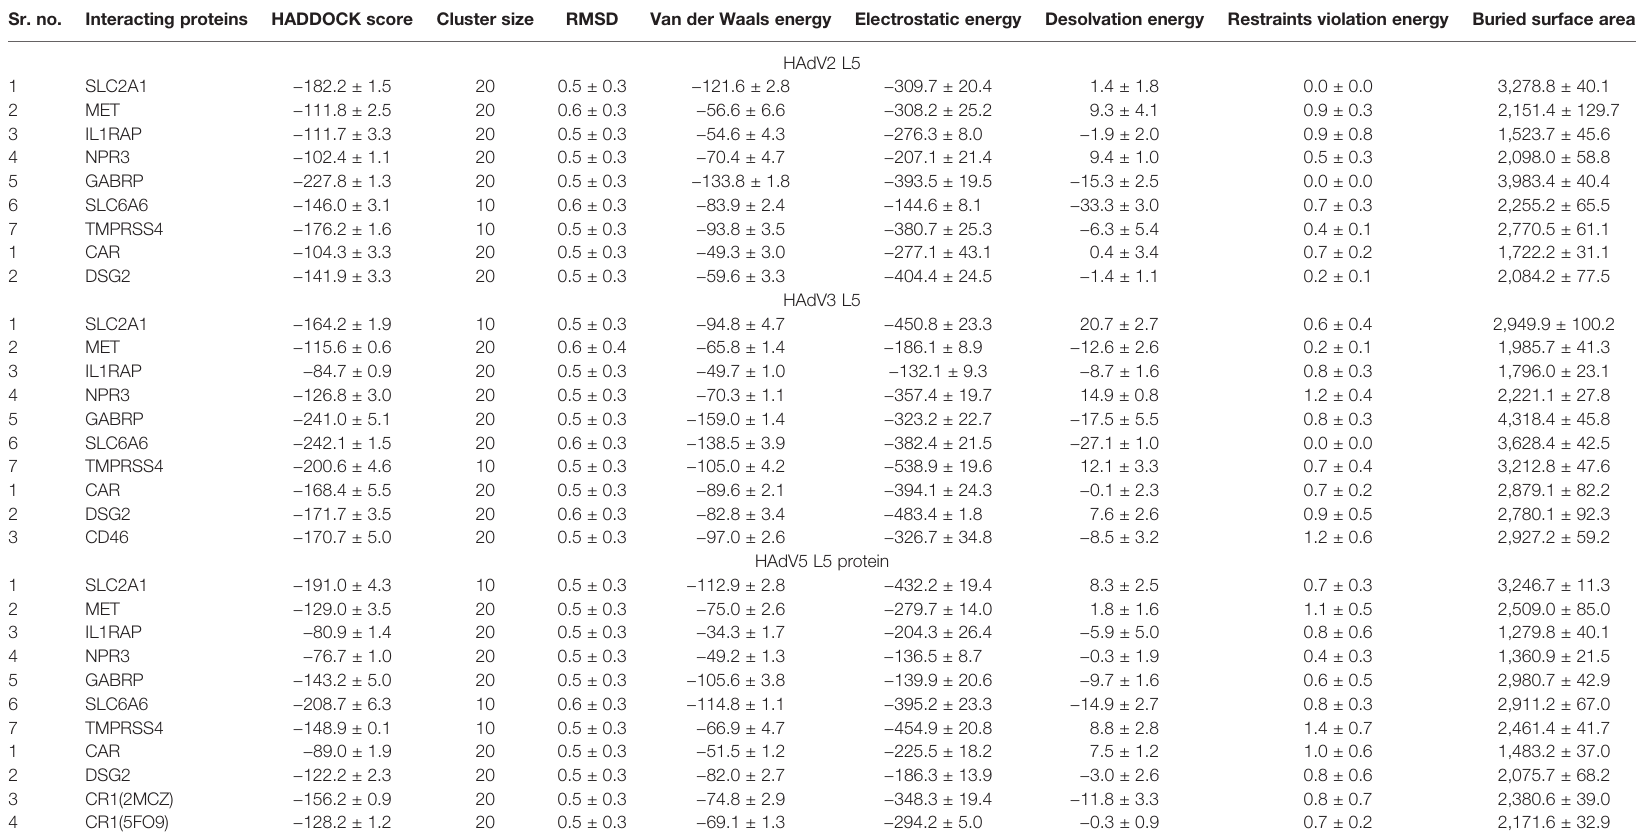
The table represents the information of re fi ned clusters for all pancreatic cancer receptors, CAR, DSG2, CD46, and CR1 against HAdv2, HAdV3, and HAdV5 L5 proteins. The HADDOCK score is protein – protein docking score, cluster size is the number of similar interaction conformations generated and clustered together by HADDOCK. RMSD (root mean square deviation) conveys how much deviation of protein structure occurs from its original conformation. Van der Waals energyisaresultofcomparativelyweakelectricforces.Electrostaticenergyreferstoelectromagneticforcethatoccurswhenamoleculeisbearingastaticelectricalcharge.Desolvationenergyisrequiredfortheinteractingproteinstosubstitute the water molecules on the binding surface. The whole calculations for each structural restraint constitute the restraints violation energy, and it is supposed to be close to